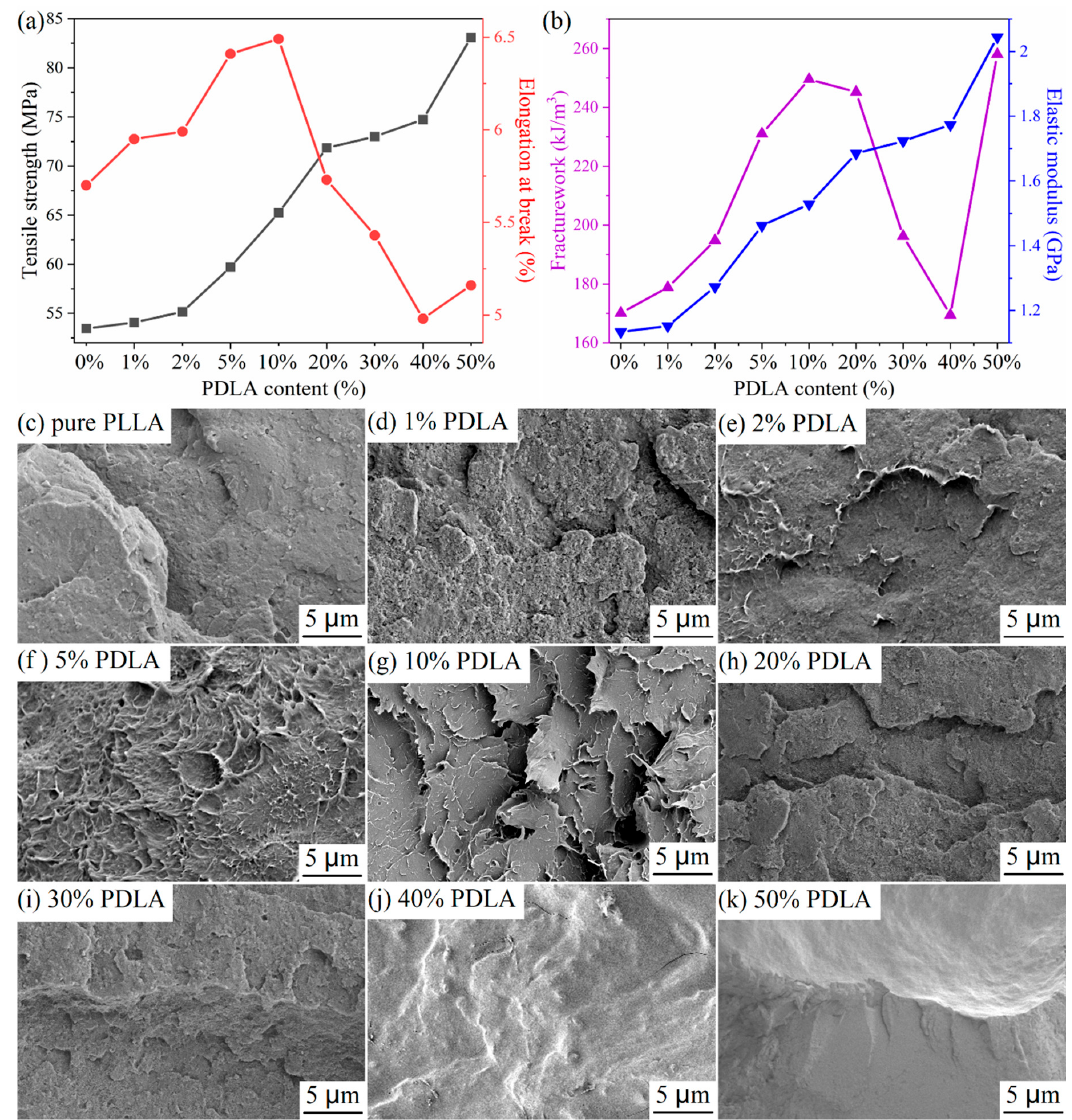
Figure 8. ( a ) Tensile strength/elongation at break, ( b ) fracture work/elastic modulus, and ( c – k ) FE-SEM images of the tensile fracture surfaces of pure PLLA and PDLA/PLLA blends with different PDLA contents.